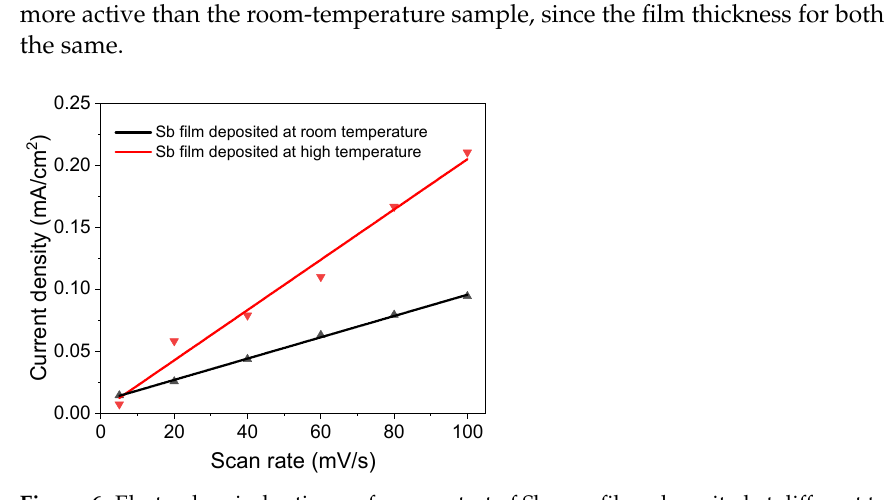
Figure 5. ( a ) Linear sweep voltammetry test of Sb nanofilms deposited at different temperatures, and ( b ) corresponding Tafel slopes.